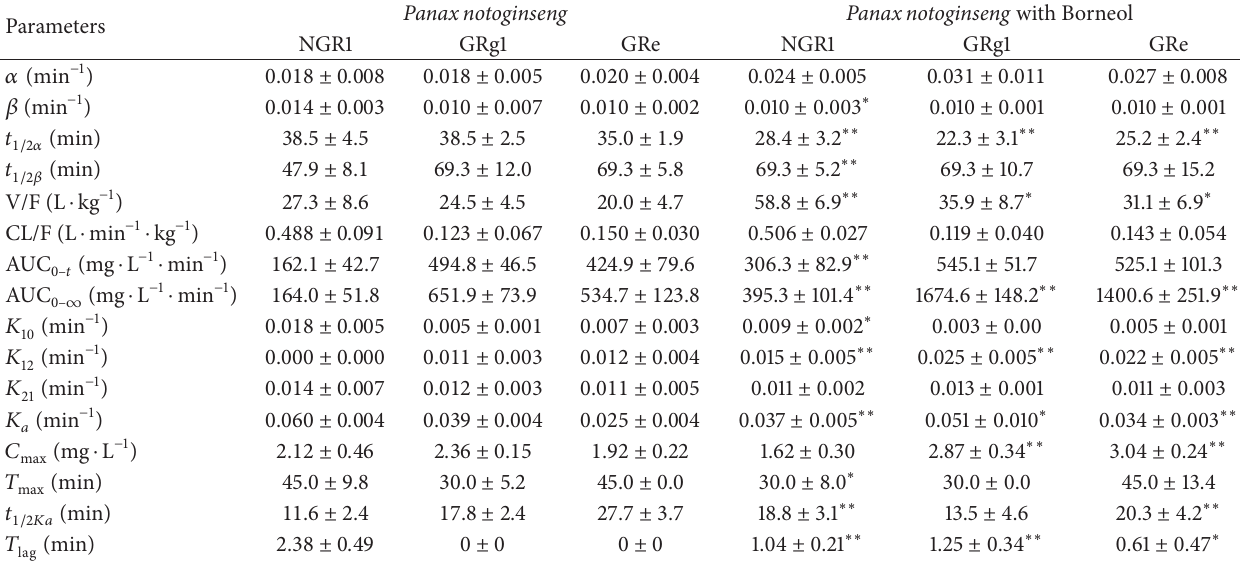
Table 4: The statistical parameters of NGR1, GRg1, and GRe after administration of Panaxnotoginseng and Panax notoginseng combined with Borneol.